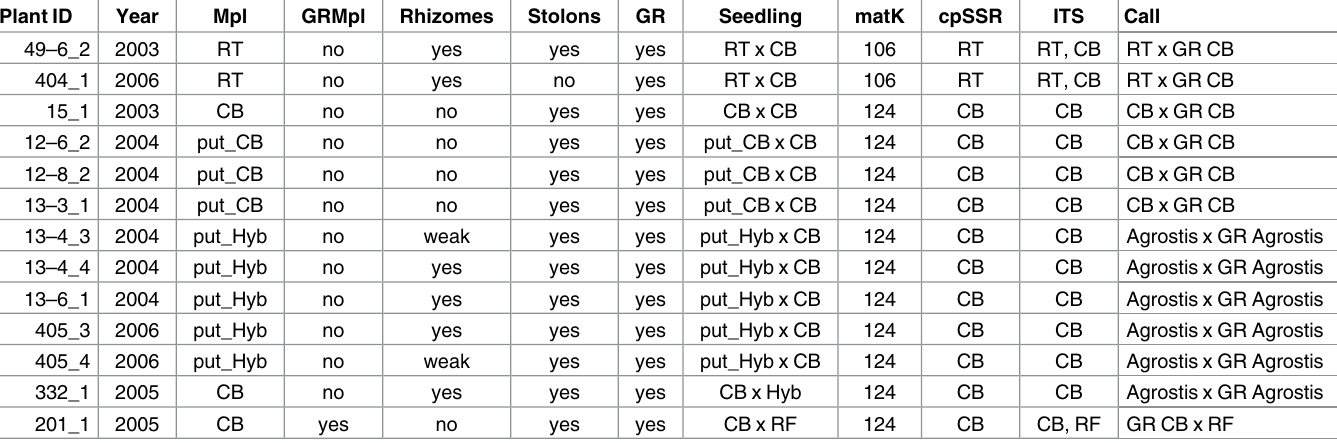
Table 3. Characteristics of seedlings screened. SeedlingID (Plant ID), year of identification (Year), type of mother plant (Mpl), glyphosate-resistance trait of mother plant (GRMpl), presenceof rhizomes and stolons in the seedling,glyphosate-resistance trait of seedling(GR), hypothesizedseedlingtype (Seed- ling), matK indel allele(matK), chloroplasthaplotype(cpSSR), ITS sequencetype (ITS), and species/hybrid call basedon all information (Call).